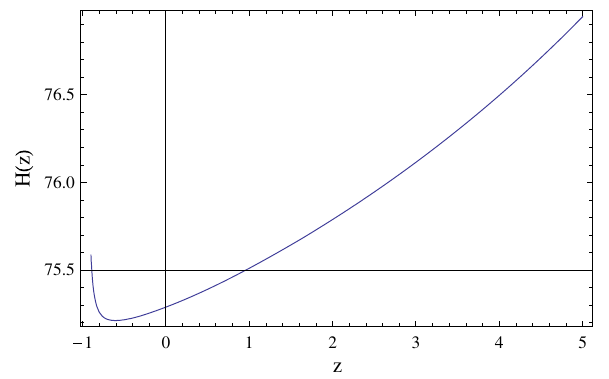
Fig. 18 Variation of H ( z ) with the variation of z (Model III) by con- sidering the best fit values w 0 = − 0 . 754 ,w 1 = 0 . 261